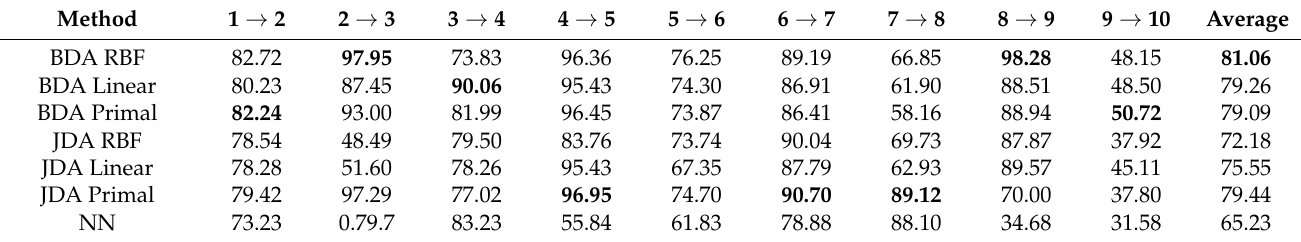
Figure 9. Comparison of recognition accuracy of different methods for Setting 2. Table 6. Drift compensation results of BDA and other methods for Setting 2.